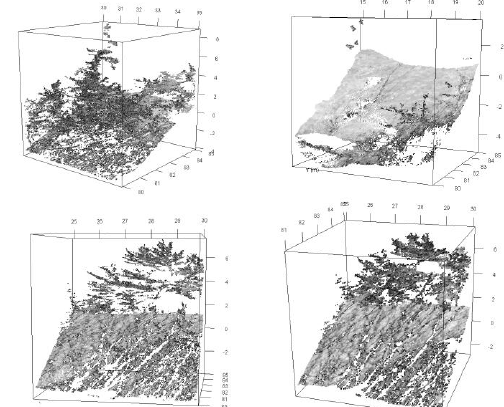
Figure 6. Parts of the control transect used to check quality.